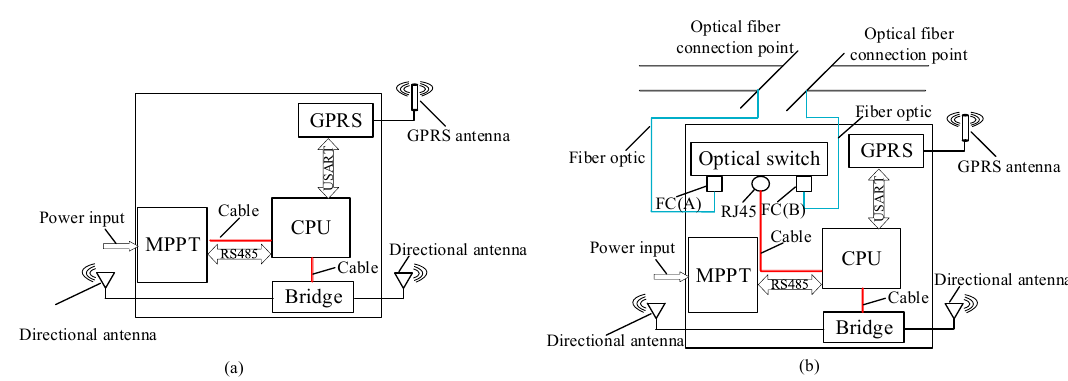
Figure 3. The communication nodes structure: ( a ) wireless relay node structure; ( b ) wireless central node structure.